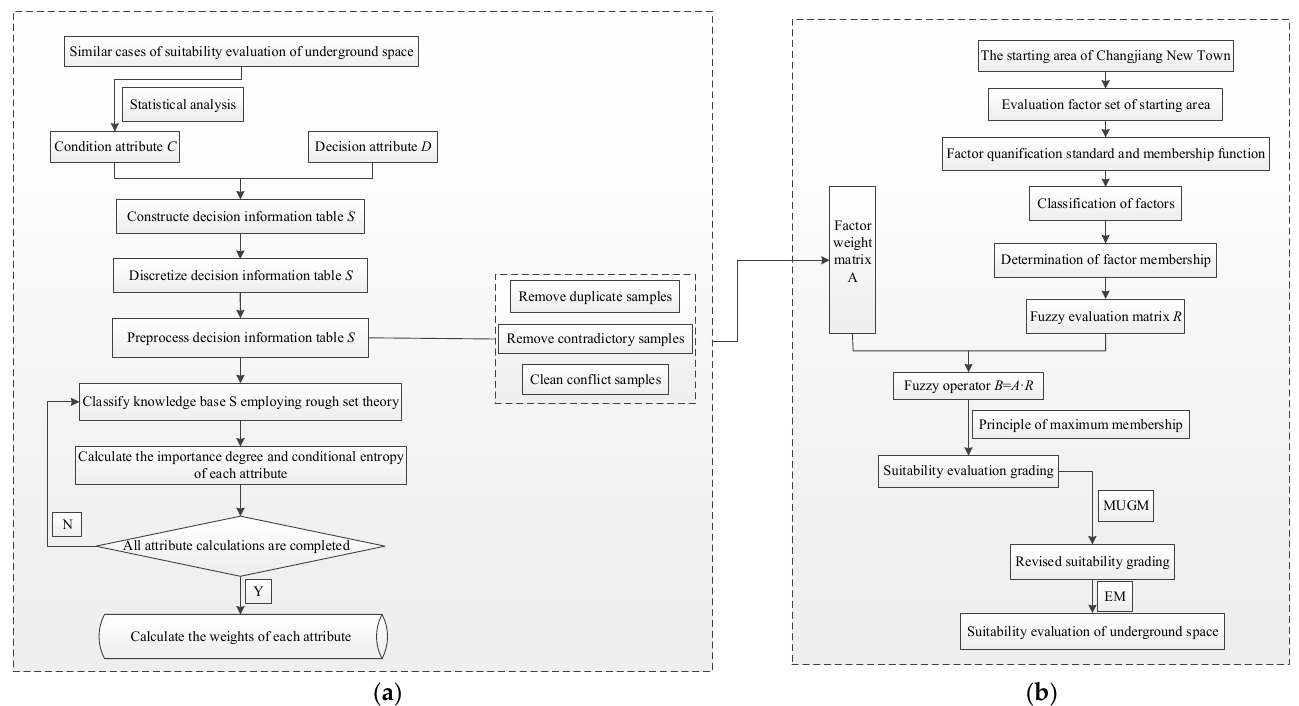
Figure 3. Technical flow chart of underground space suitability evaluation based on rough set and conditional entropy: ( a ) flow chart of weight calculation based on rough set and conditional entropy; ( b ) flow chart of fuzzy comprehensive